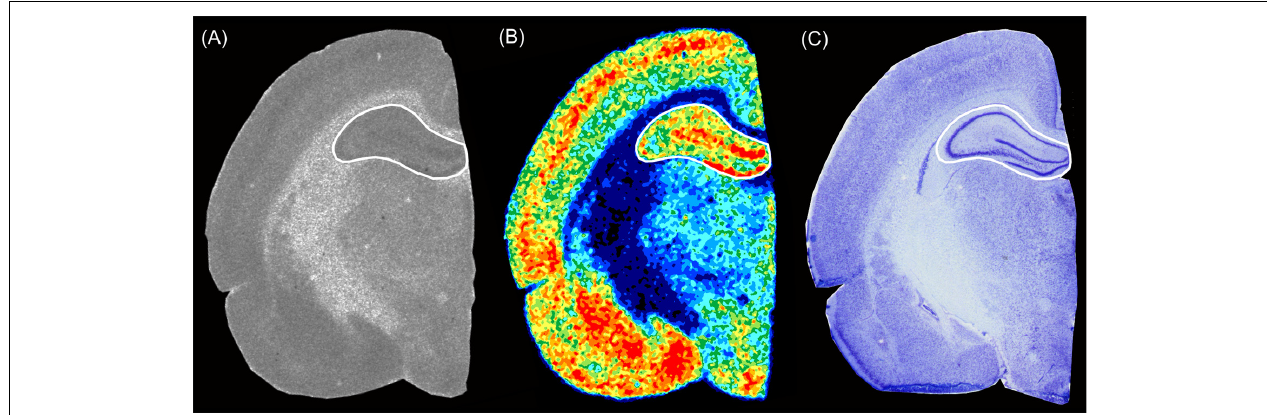
FIGURE 1 | Exemplary section from a P20 rat brain showing the hippocampal level of (A) an autoradiographic image of [ 3 H]SR 95531 binding to GABA A receptors, (B) the respective color-coded image of the same autoradiographic image, and (C) an adjacent Nissl stained section. The Paxinos and Watson rat brain atlas (Paxinos and Watson, 2005) was used to verify the regions of